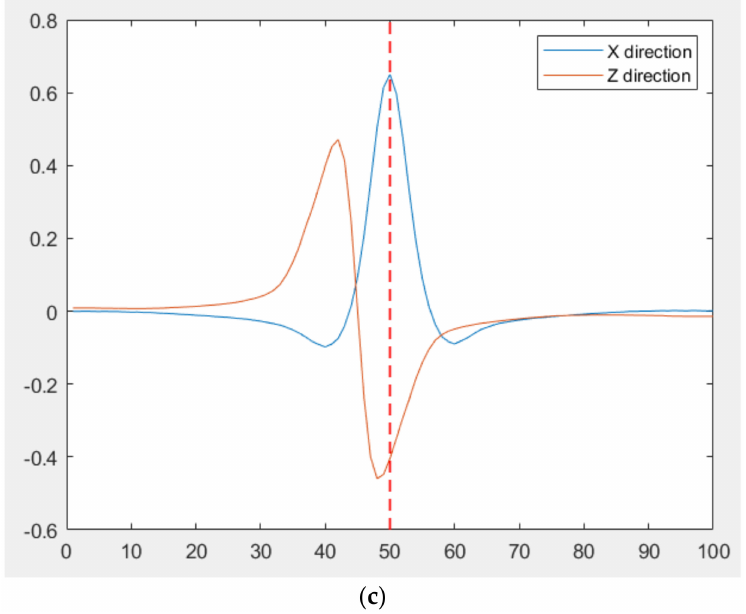
Figure 7. The x and z direction simulation results with different distance. ( a ) 1.8 mm; ( b ) 2.2 mm; ( c ) 2.6 mm.